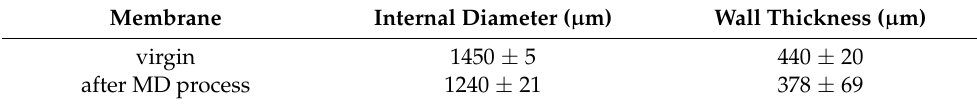
Table 1. Dimensions of capillary PTFE membranes used in the present study.